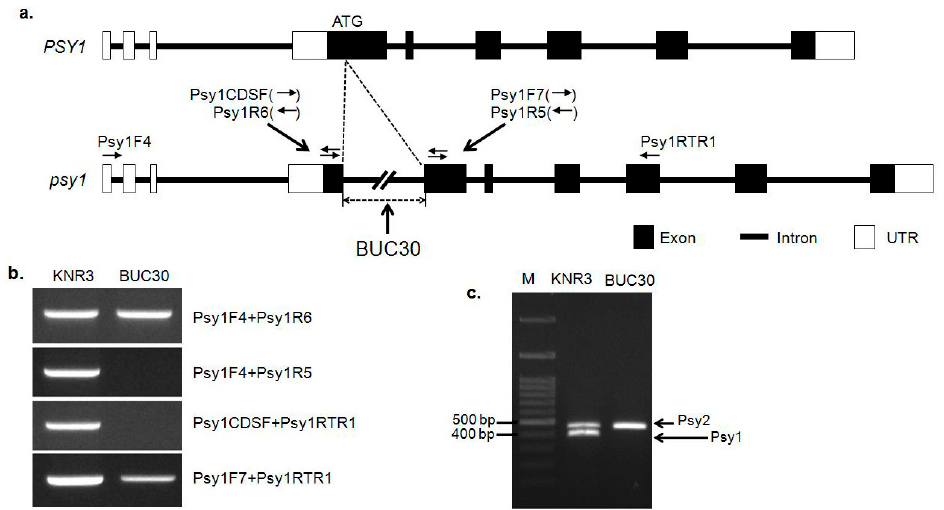
Figure 2. Gene structures of the wild-type and mutated forms of Psy1 and their amplification products using different sets of primers designed at different positions of the gene to detect mutations. ( a ) Representation of the putative long insertion in Psy1 , which causes the green fruit in BUC30 (lower panel) compared to normal Psy1 in the red-fruited line; ( b ) PCR amplification of Psy1 from the individual inbred lines with different primers sets. The primers sets include: 5 ′ -UTR forward (Psy1F4), exon 1 reverse (Psy1R5 and Psy1R6), exon 1 forward (Psy1CDSF and Psy1F7), and exon 4 reverse (Psy1RTR1). Amplicons were seen in the red-fruited inbred line (KNR3) when the Psy1F4 +